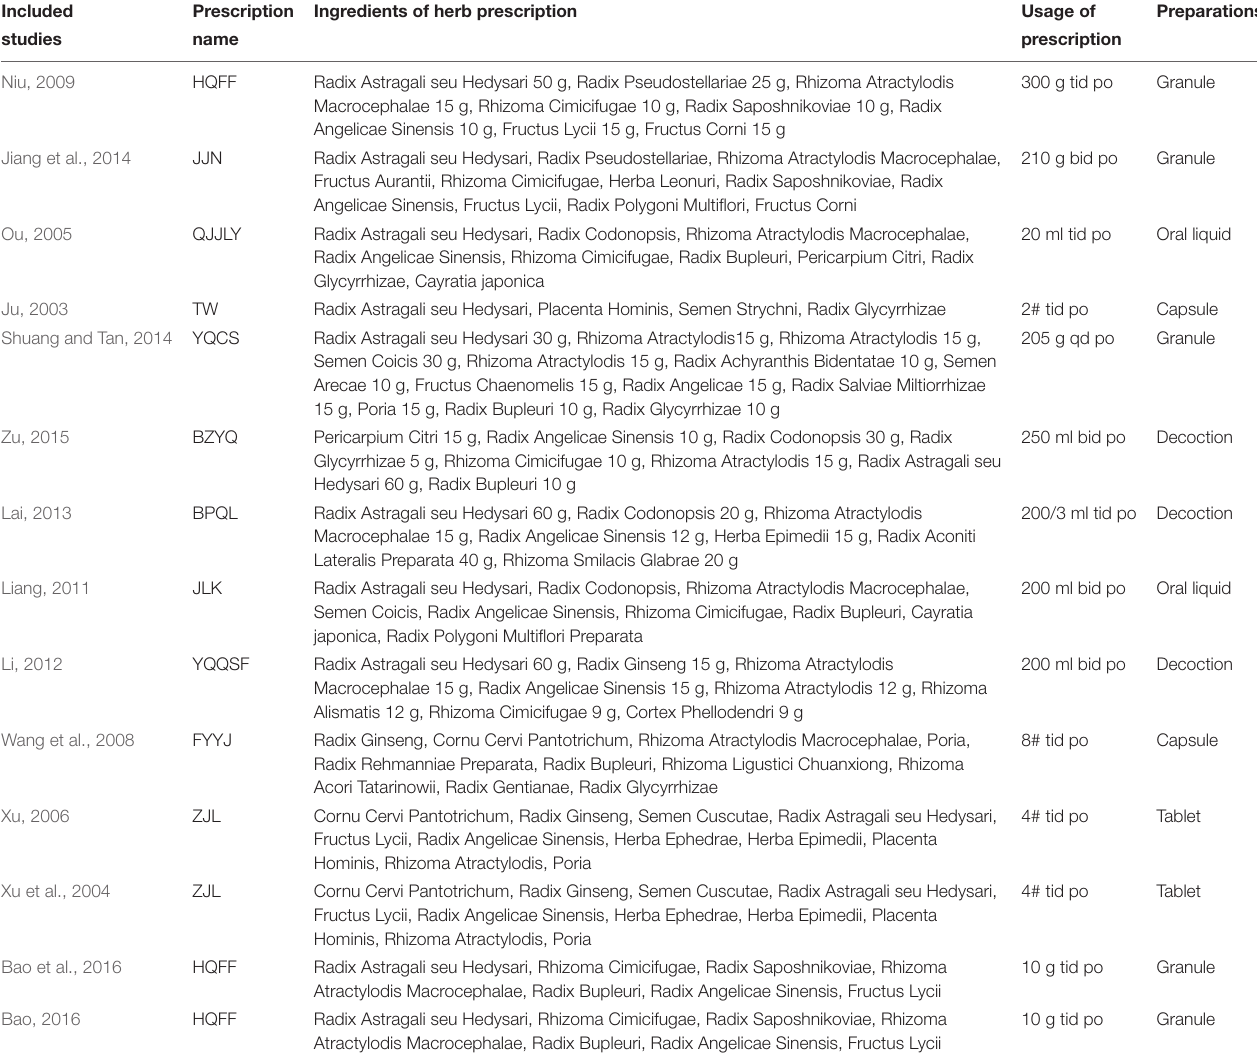
TABLE 2 | Ingredients and usage of CHM.